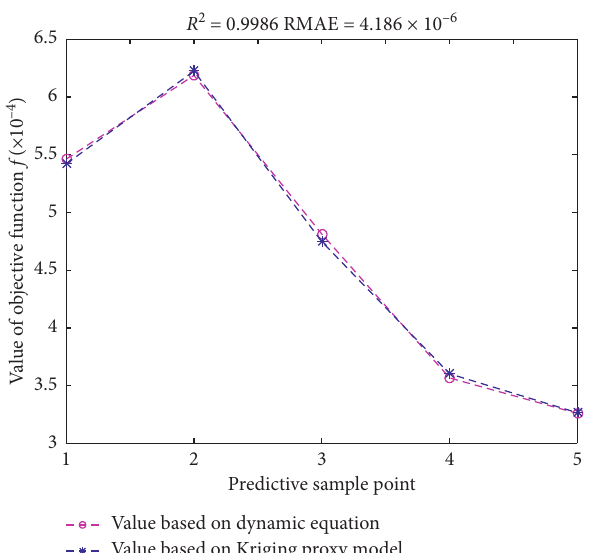
Figure 8: Comparison of the objective function value f by solving dynamic equation and Kriging proxy model when m are considered as design variables.